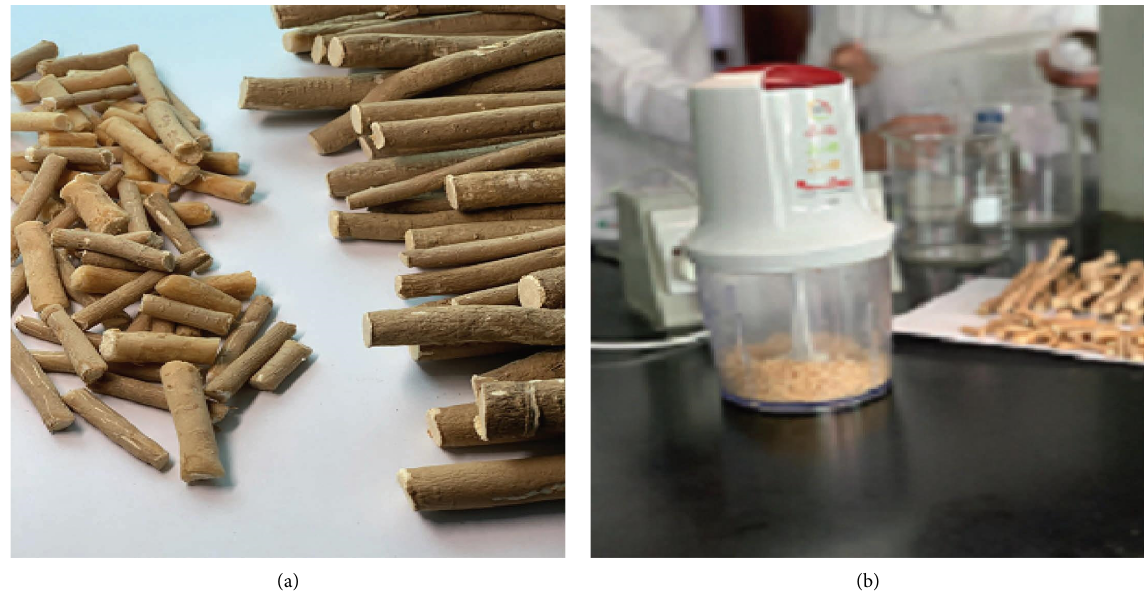
Figure 1: (a) Stem bark of Salvadora persica (miswak) and (b) miswak pulverised in a mechanical